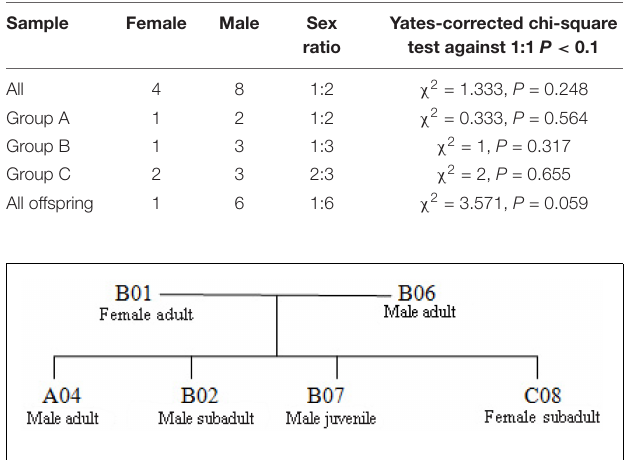
TABLE 4 | Sex ratio of the Hainan gibbon study population.